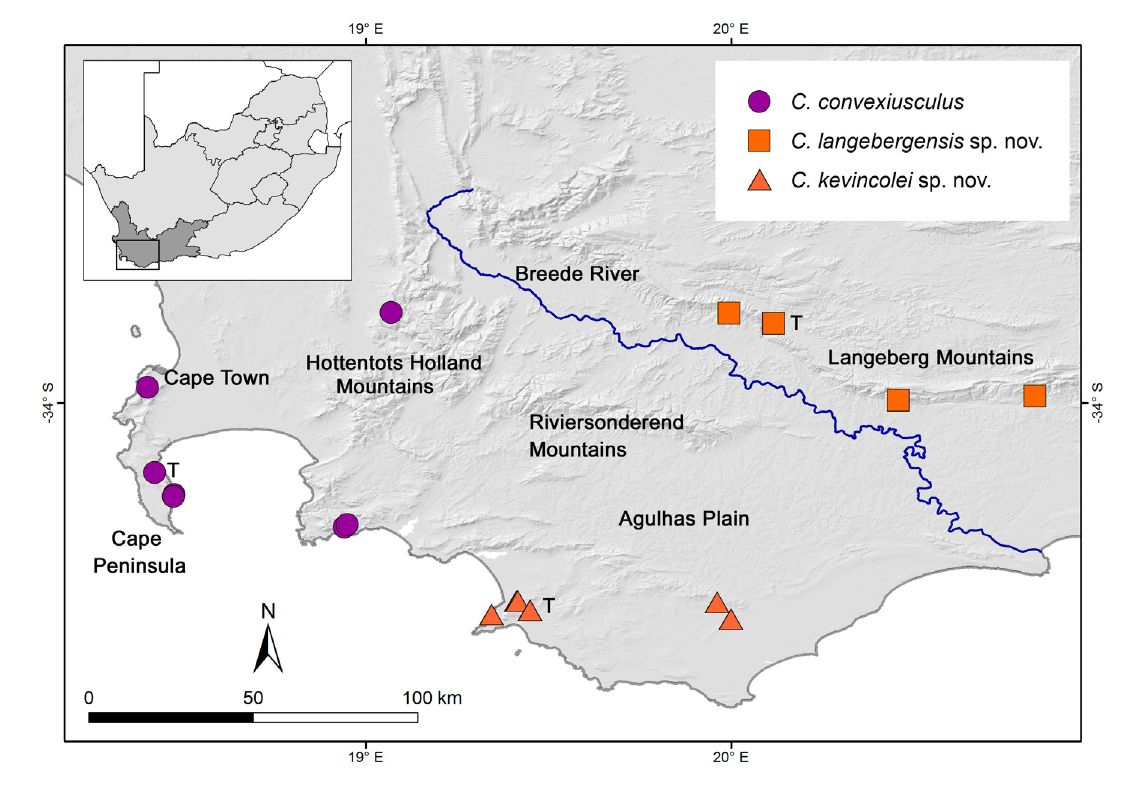
Fig. 5. Distribution map of the two major clades in the Western Cape province, the Southwestern Cape clade (purple) and the Overberg clade (orange). T indicates